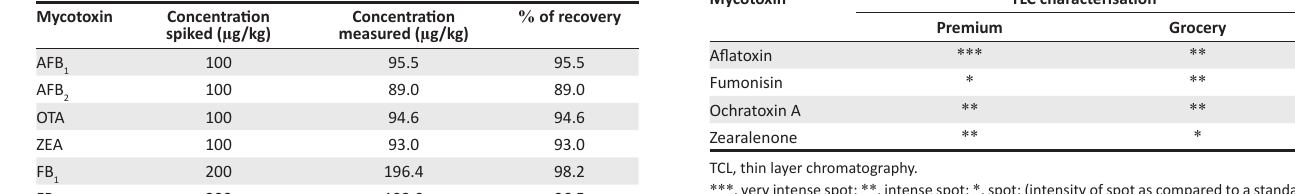
TABLE 1: Mean recoveries of selected mycotoxins after spiking in feed samples using high performance liquid chromatography. Mycotoxin